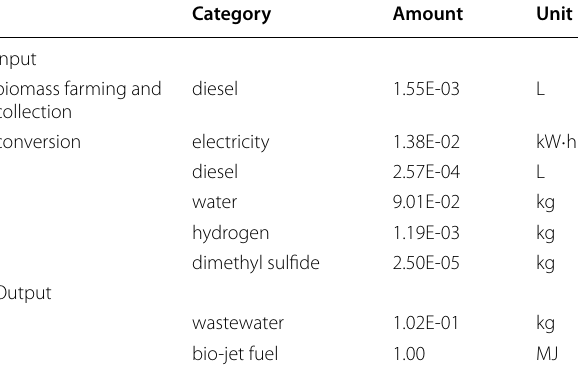
Table 3 LCI for HTL technical path